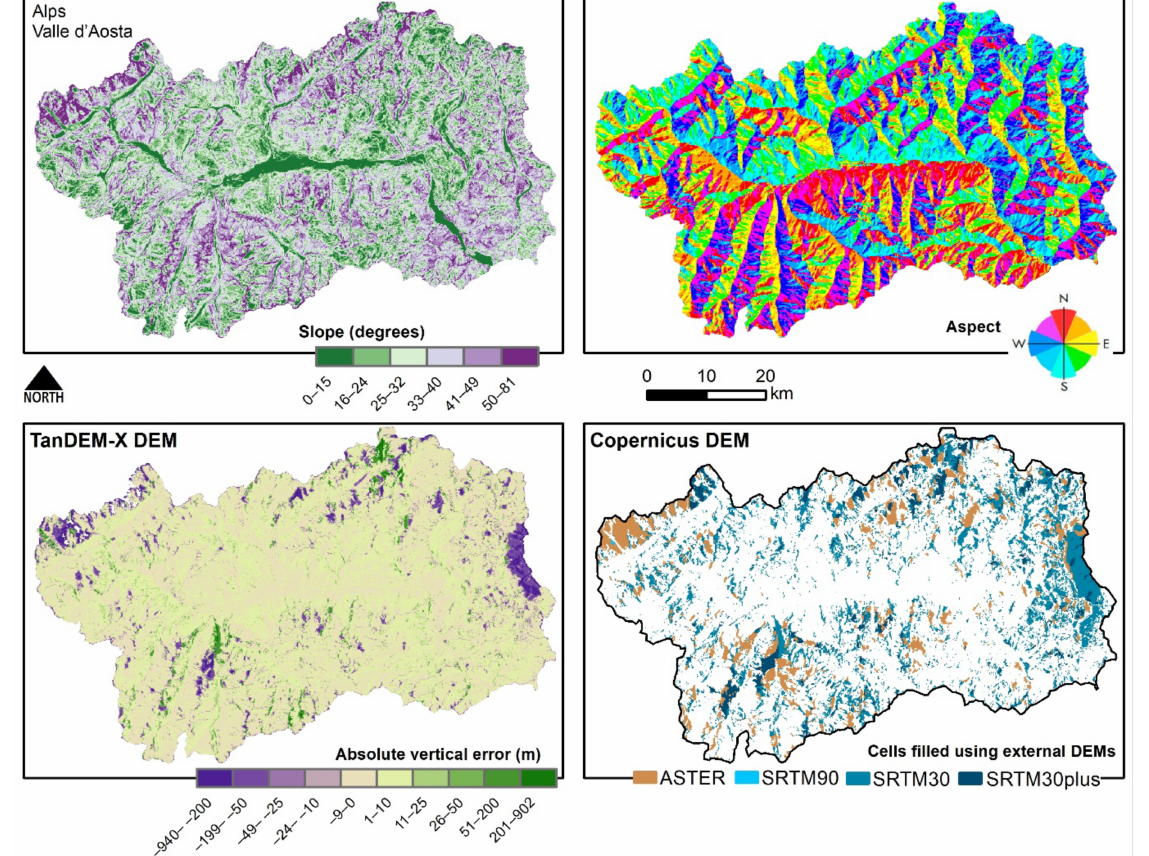
Figure 3. Slope, aspect, and absolute vertical error of the TanDEM-X DEM and the fill source of COP90 in the Alps’ study area. Note that largest absolute vertical errors mostly coincide with areas of very steep slopes of east- and west- orientation. Note the correspondence between sites of high vertical error and COP90 sites, which were filled with external reference data (filling